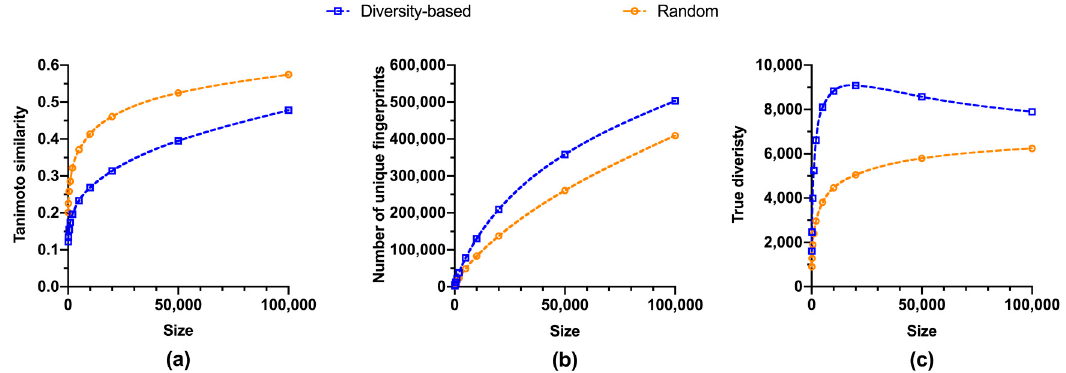
Figure 1. Structural diversity vs size of fragment libraries, with the former measured by: ( a ) Average of the similarity of each compound to its closest neighbor; ( b ) total number of unique fingerprints (richness); ( c ) true diversity calculated by equation 1. Dash curves are generated from cubic spline fitting. Metrics for random selections are average values of triplicates (Table S2).